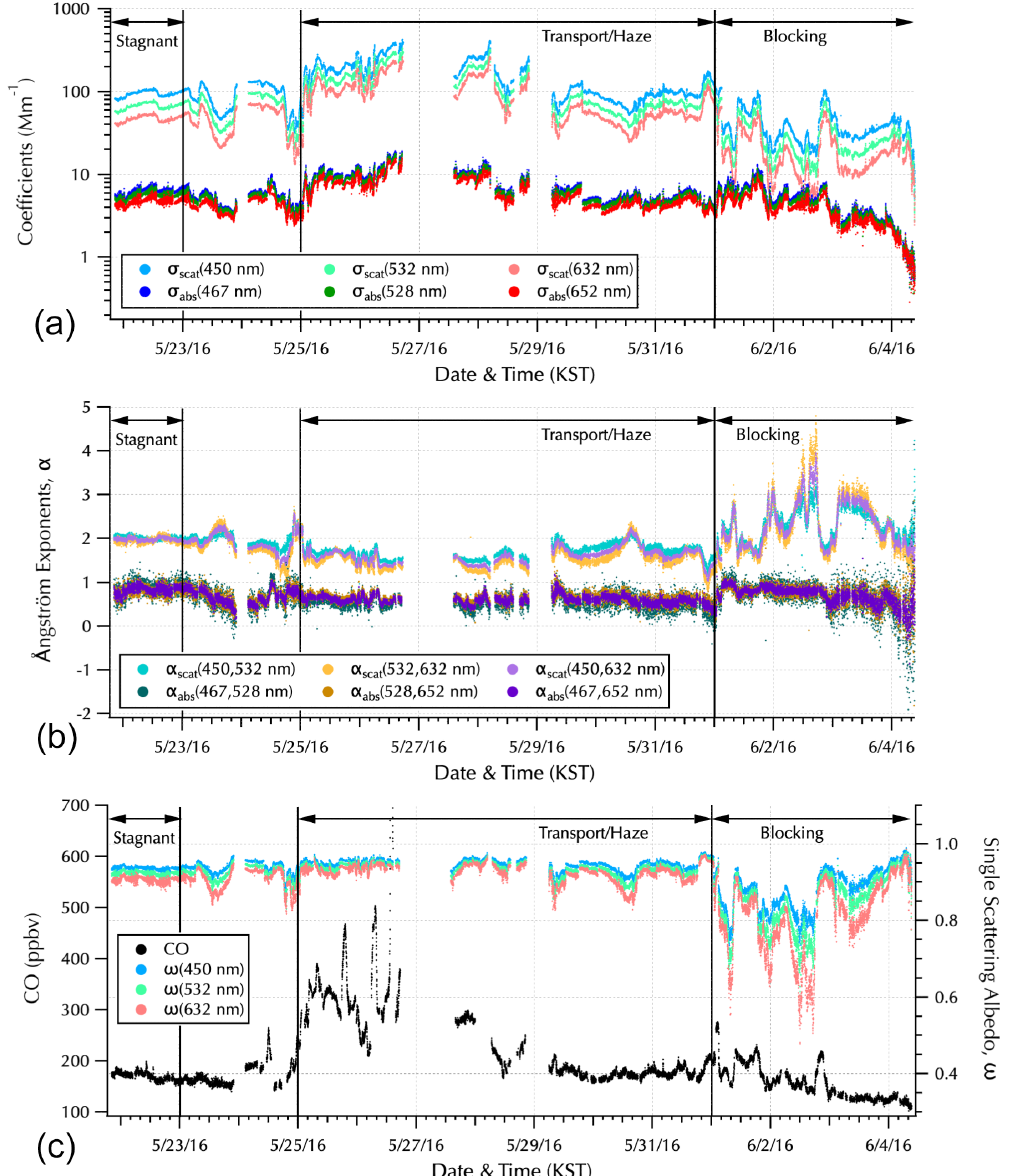
Figure 2. (a) σ scat (light shades) and σ abs (dark shades) averaged to 1min intervals during the cruise (both in units of Mm − 1 ). (b) α scat (light shades) and α abs (dark shades), unitless, calculated from the wavelength pairs of the coefficients in the top panel. (c) ω (right axis), unitless, along with 1min averaged CO concentrations (ppbv). Note that the peak CO value cutoff in the figure reached